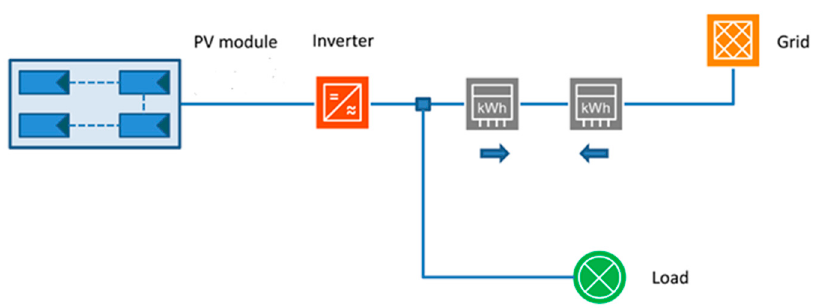
Figure 4. Schematic representation of the grid-connected PV system.